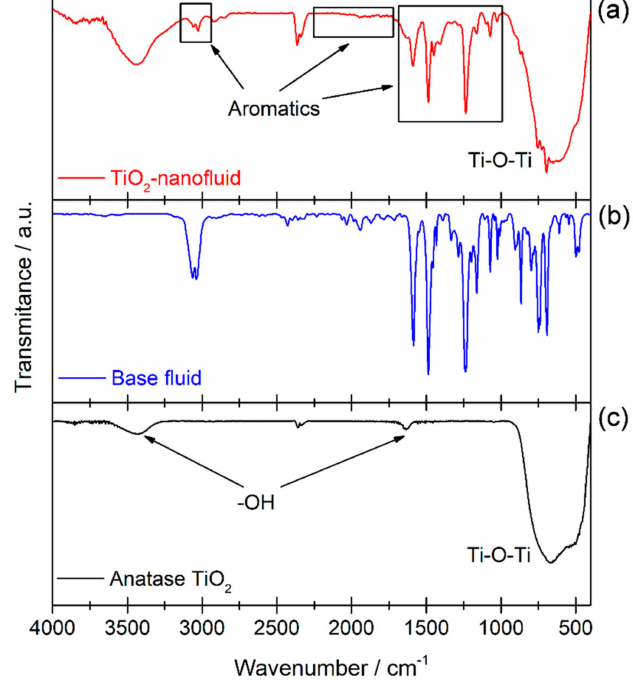
Figure 5. Fourier Transform Infrared (FTIR) spectra of TiO 2 sample extracted from the nanofluid ( a ), base fluid ( b ), and reference TiO 2 anatase ( c